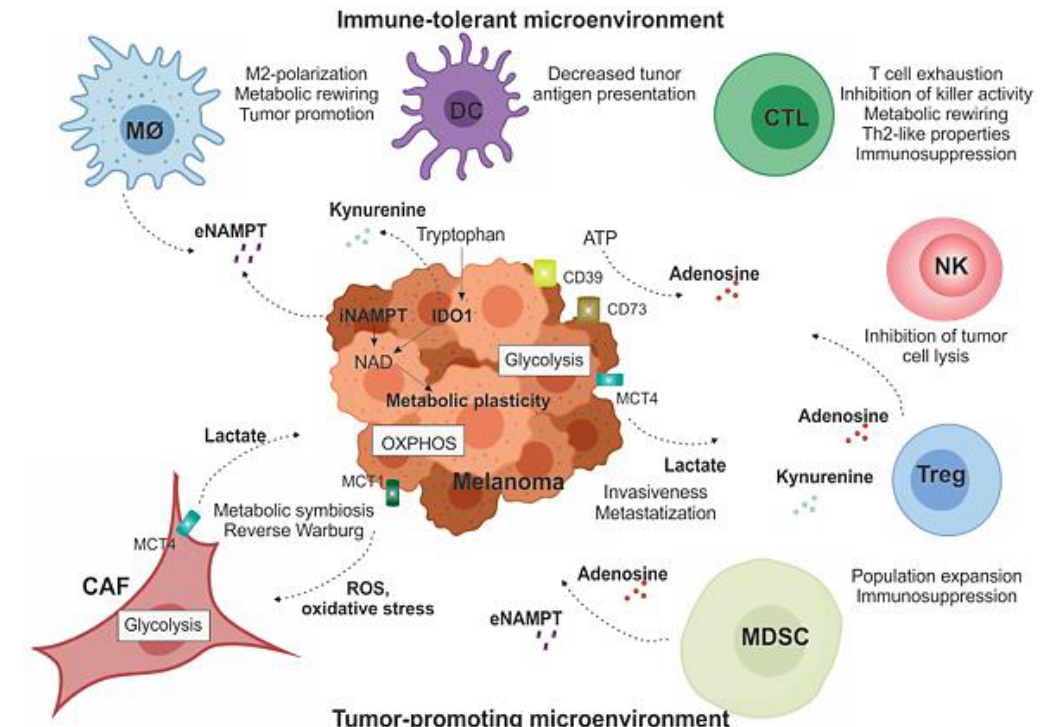
Figure 3. Soluble factors and immunometabolic interplay within the TME. Melanoma is usually surrounded by a wide array of stromal cells (CAFs) and infiltrating immune cells of both innate and acquired immunity, such as MDSCs, MO-TAMs, DCs, NK cells, and T lymphocytes. They form complex interactions and exchange of soluble factors with melanoma cells that modulate metabolic plasticity of cellular components and support tumor growth by creating a tolerogenic environment that enables cancers to evade immune surveillance and destruction, as detailed in the text. MO-TAM: tumor-associated macrophages; DC: dentric cell; CTL: cytotoxic T lymphocytes; NK: natural killer cell; Treg: T-regulatory lymphocyte; MDSC: myeloid-derived suppressive cells; CAF: cancer-associated fibroblasts.